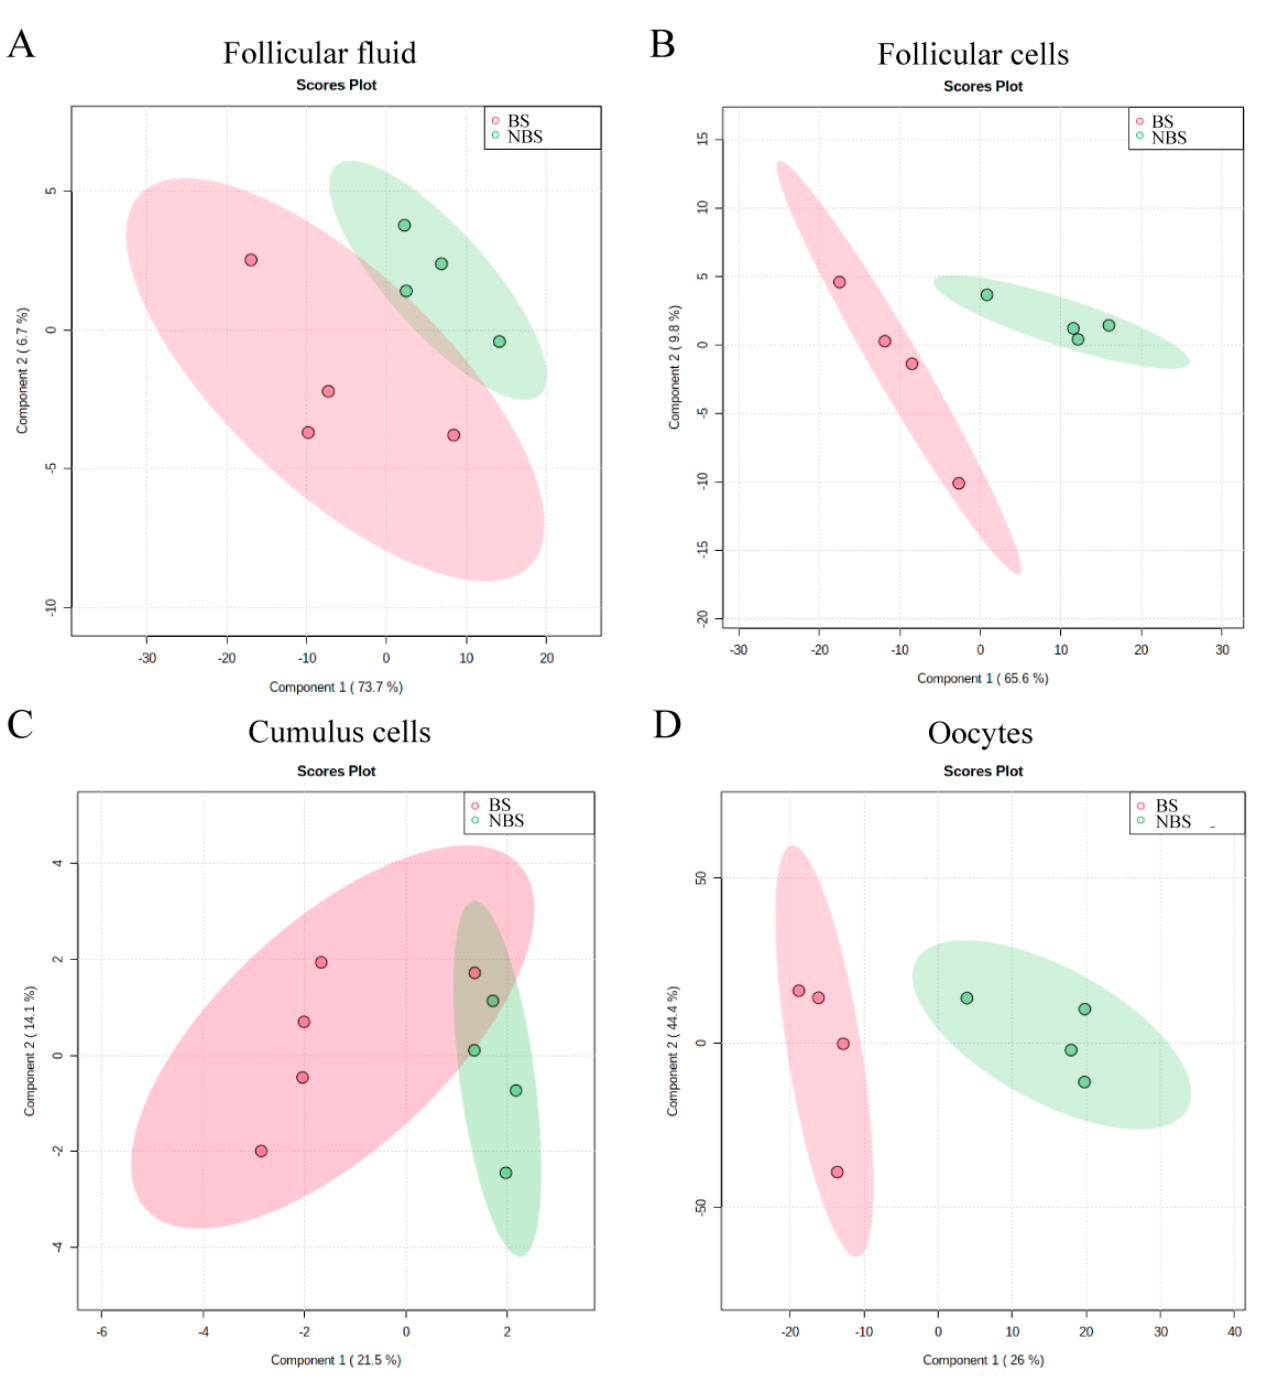
Figure 1. Score plot of samples collected during the breeding season (BS) and the non-breeding season (NBS): ( A ) follicular fluid; ( B ) follicular cells; ( C ) Cumulus cells; and ( D ) Oocytes.